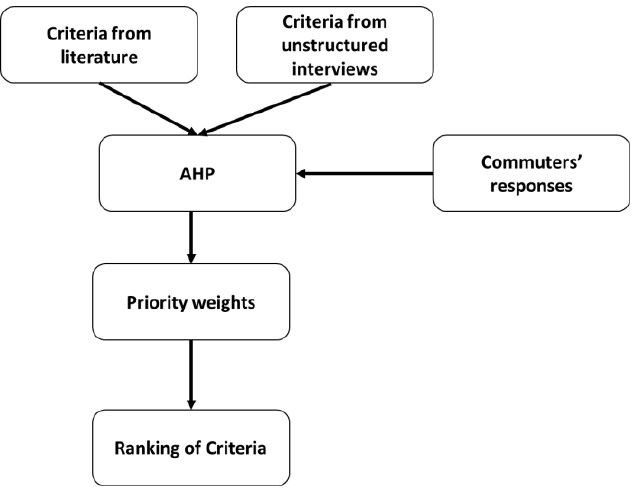
Figure 1. Methodological